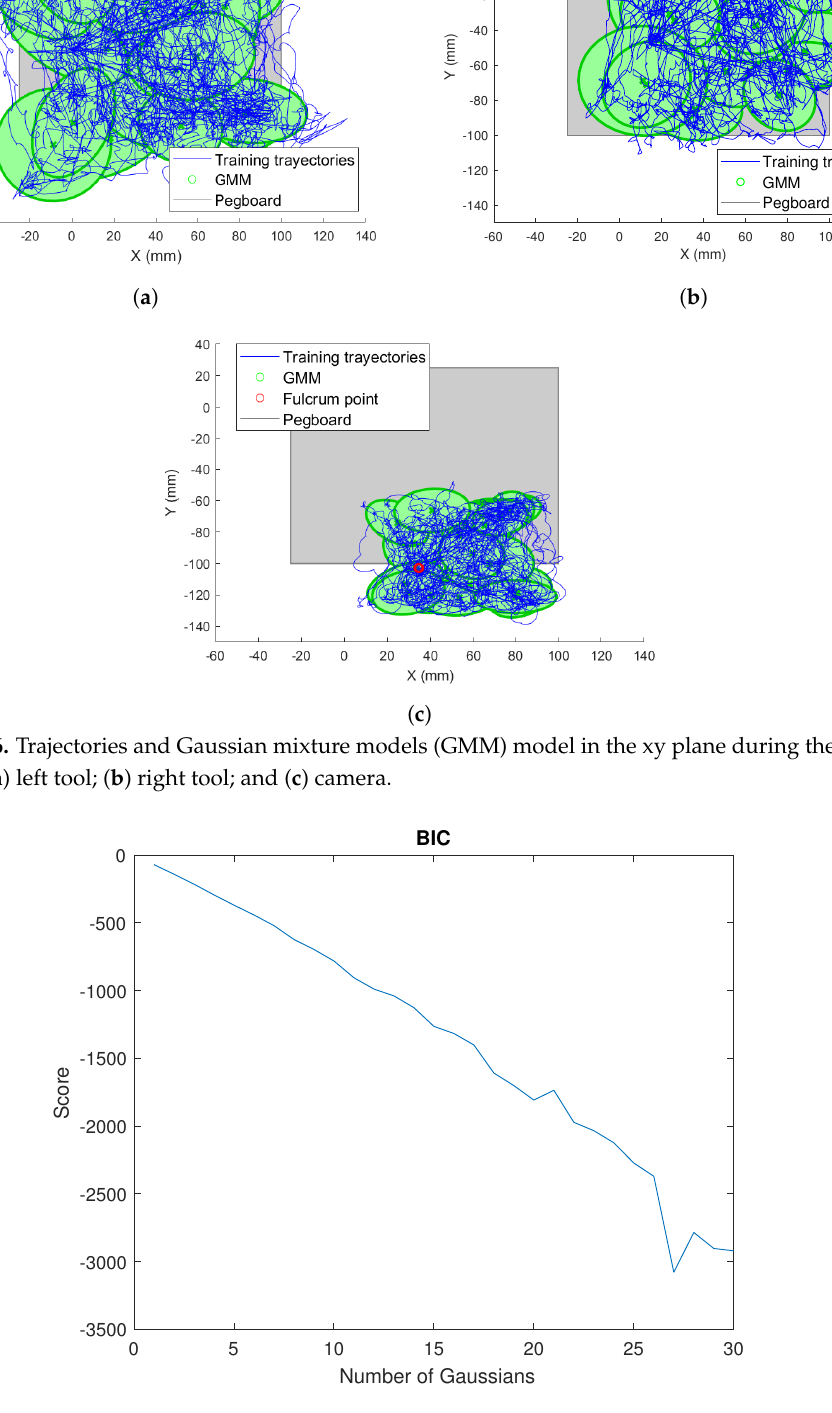
Figure 7. Bayesian information criterion (BIC) score for the generated GMM using the training sequence. The score is decreased (improved) as the number of gaussians are